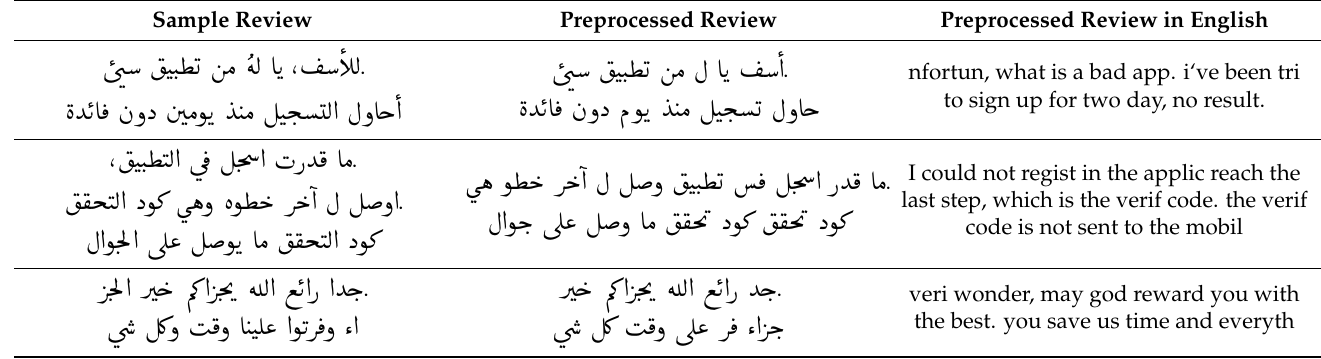
Table 6. Sample tweets after